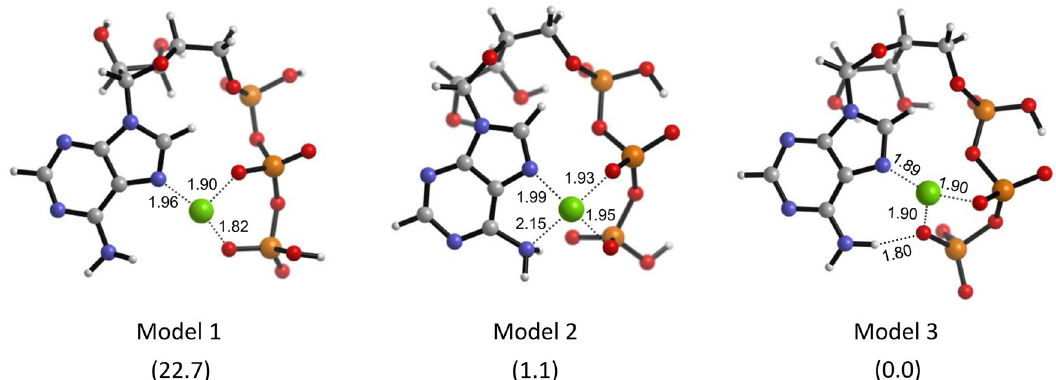
Supplementary Fig. 22. The proposed models of Cu 2 + ⋅ ATP. The relative electronic energies are in the parenthesis with a unit of kcalmol − 1